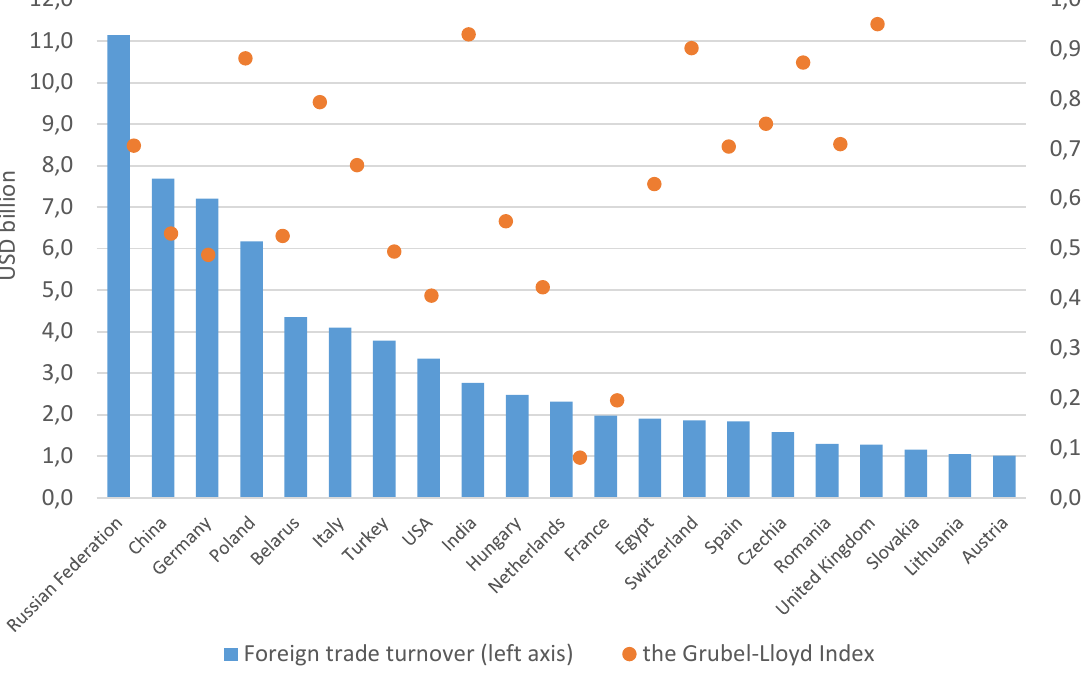
Figure 2. The Grubel-Lloyd index for the countries with the largest foreign trade turnover (in relation to Ukraine),